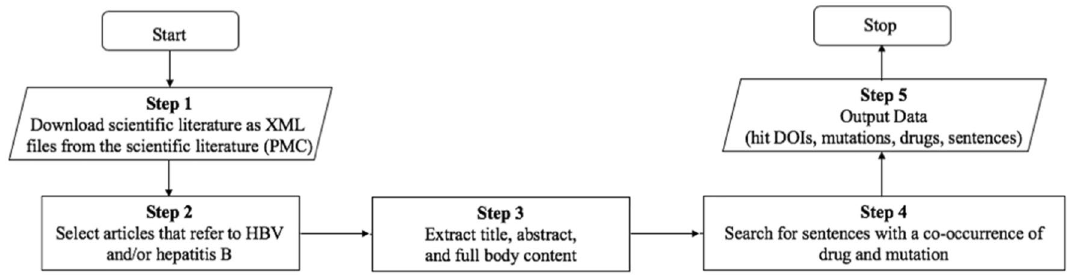
Figure 1. Workflow for mining the scientific